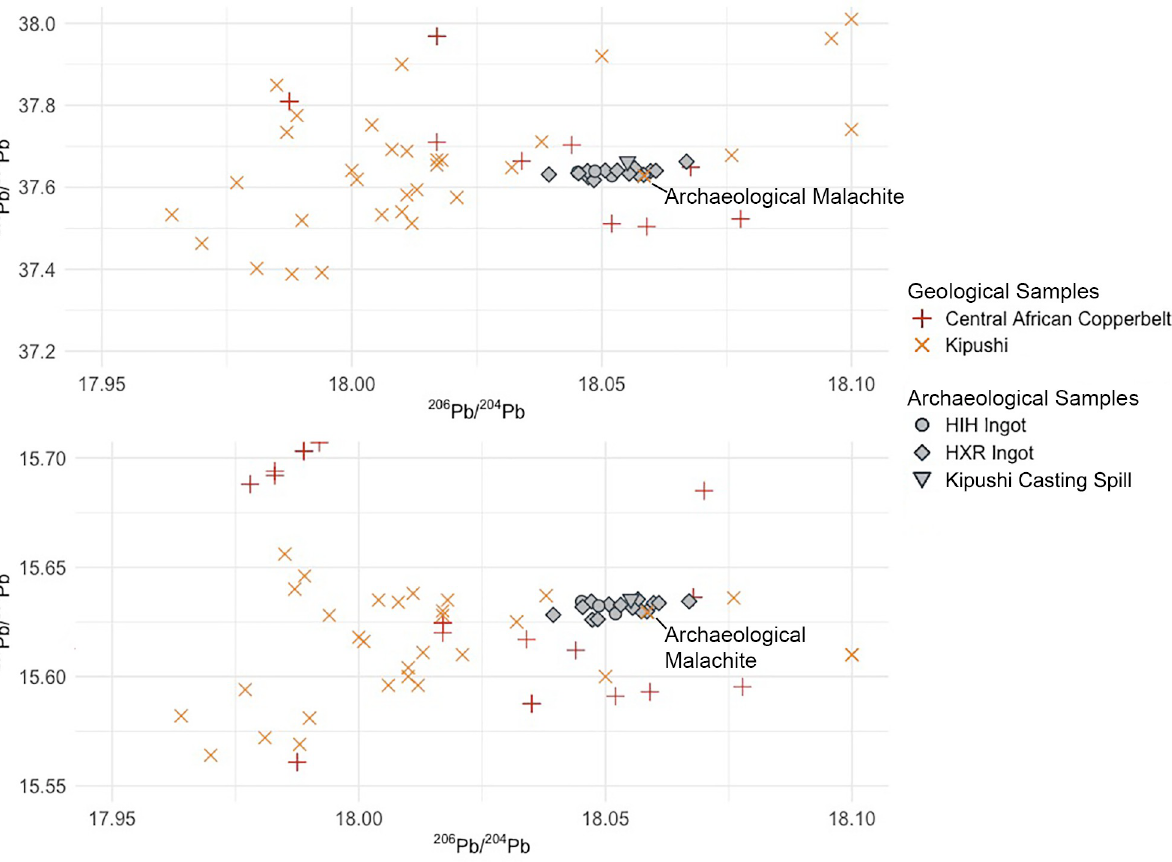
Fig 9. Highlighted samples from Fig 8. A zoomed-in perspective of the highlighted box from Fig 8 shows the highly clustered group of HIH and HXR ingot samples which match to LIA data from the Zn-Pb-Cu Kipushi deposit. Note that the scale is drastically different from Fig 8 . Included in this plot are one copper casting spill and one fragment of malachite recovered from smelting sites near Kipushi. Present in this narrow window are 30 datapoints from ore samples from the Kipushi deposit, and 9 datapoints from 7 other deposits within the Copperbelt that are closest to the Kipushi cluster. Ore data in the S3 Appendix from compilation of Killick et al. [59] and data produced by Stephens in